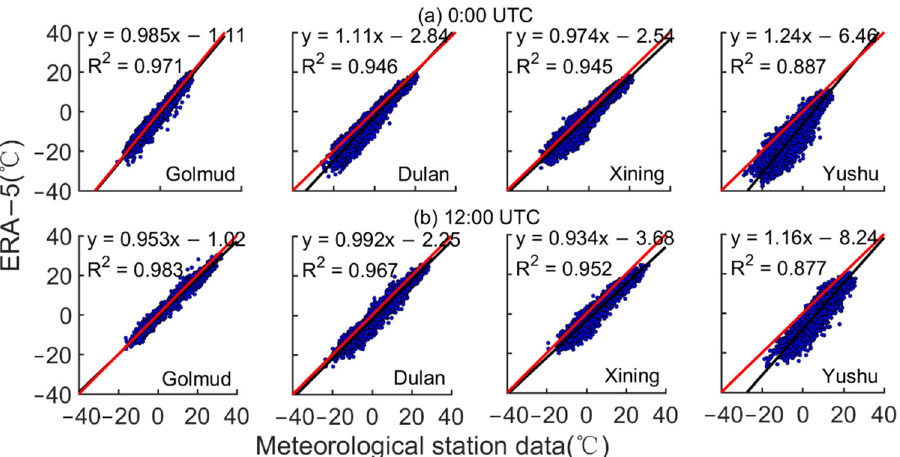
Figure 12. Distribution of temperature scatter points of radiosonde and ERA-5 data at a distance of 2 m from the ground. (black solid line: scatter linear fitting; red solid line: y = x). ( a ) At 0:00 UTC, 2 m temperature scattered points were distributed in Dulan, Xining, Golmud, and Yushu station. ( b ) At 12:00 UTC, 2 m temperature scattered points were distributed in Dulan, Xining, Golmud, and Yushu station.